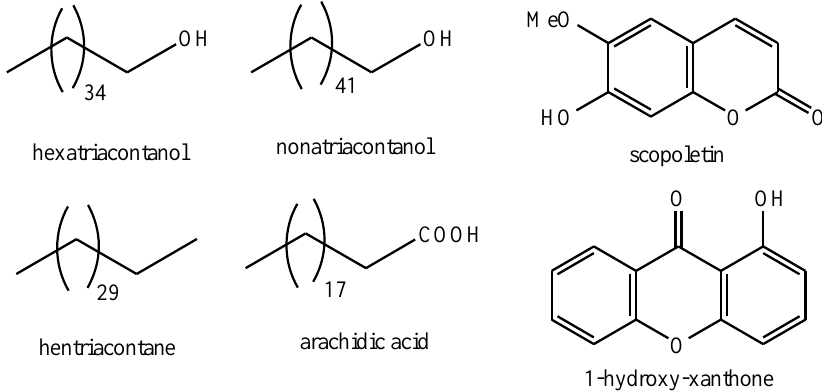
Figure 3. Fatty acids, alkanes, alkyl alcohols, coumarins, and xanthones identified in Pedicularis species.